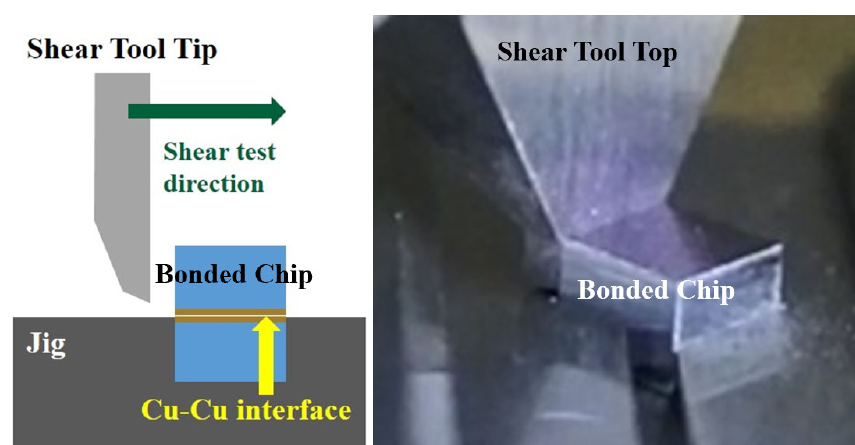
Figure 2. Equipment setup for the s hear measurements. Table 1. Chip bonding conditions.